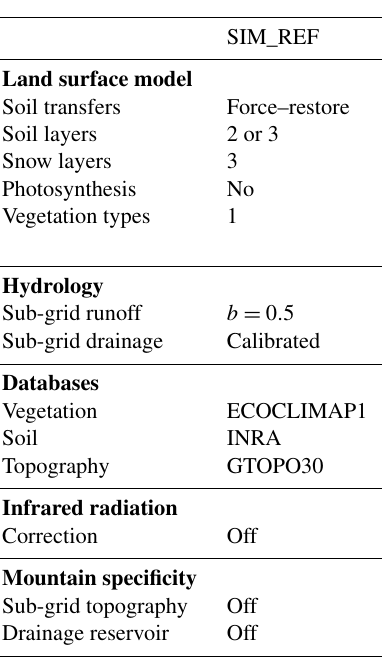
Table 1. Main characteristics and differences in